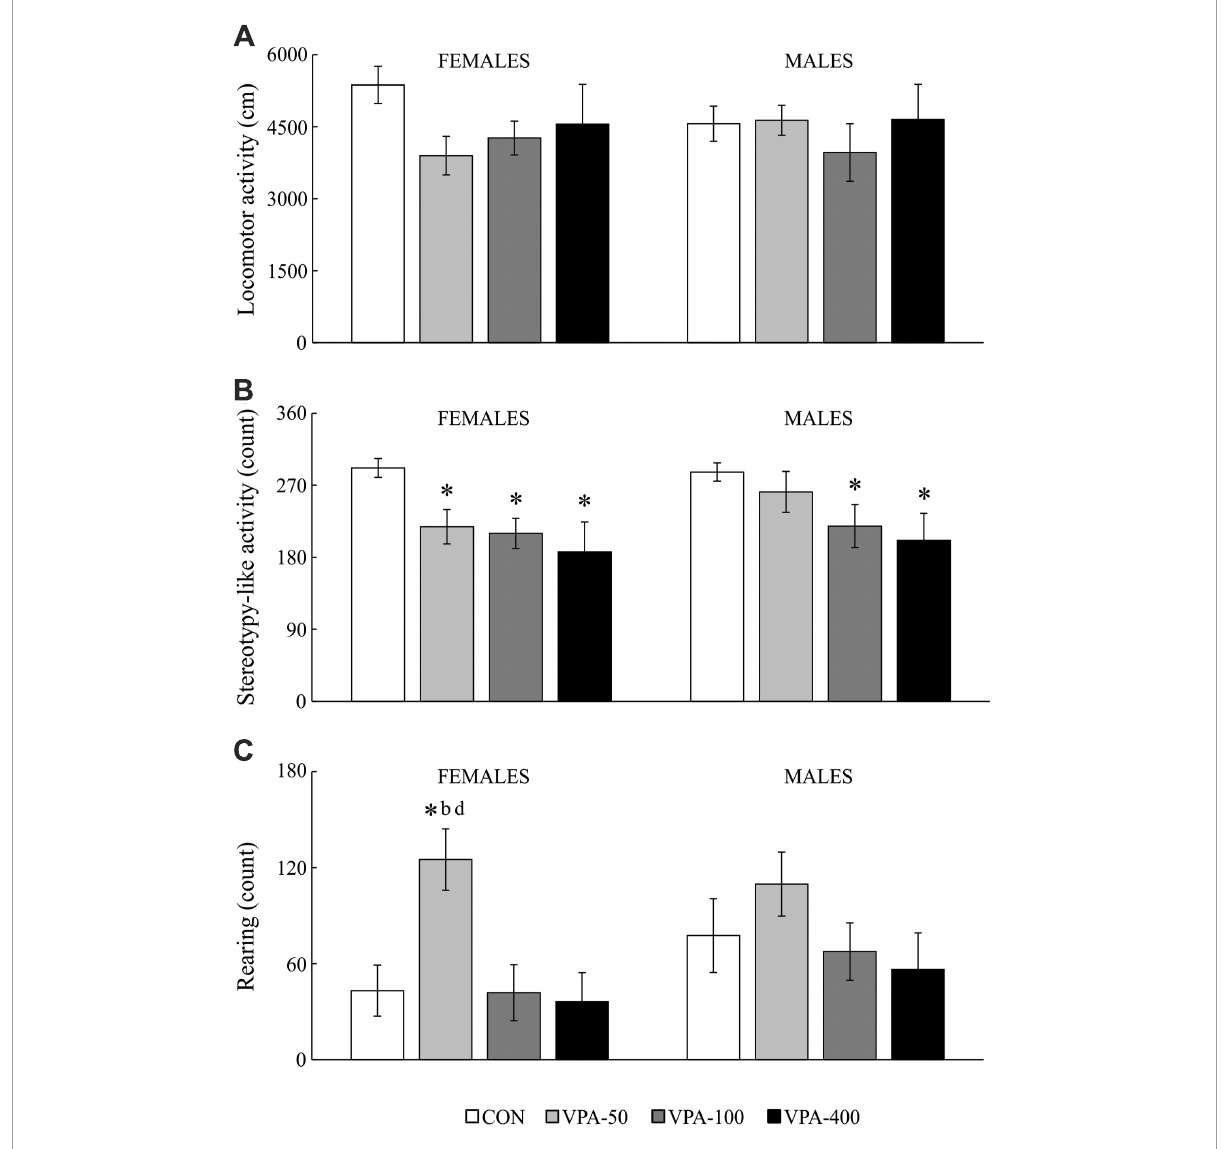
FIGURE4 Locomotor activity (A) , stereotypy-like activity (B) , rearing (C) in adolescent female and male mice prenatally exposed to VPA at doses of 50 mg/kg (VPA-50), 100 mg/kg (VPA-100), and 400 mg/kg (VPA-400) on the PND40. The VPA-200 group was not examined in the OFT because of the absence of behavioral changes in the EPMT. Each bar represents the mean ± SEM ( n = 7 mice/group/sex). * p < 0.05 compared to the control (CON) group treated with saline; b p < 0.05 compared to the VPA-100 group; d p < 0.05 compared to the VPA-400 group ( U